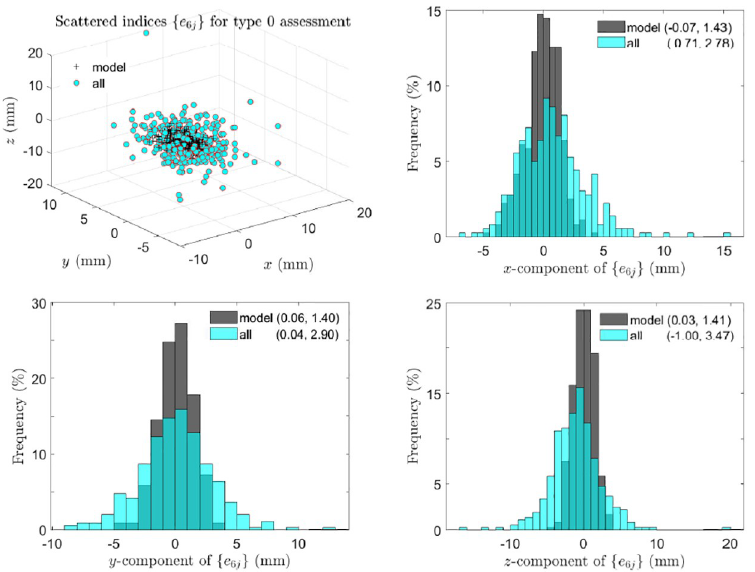
Fig 7. Type 0 assessment: Directional asymmetry of landmark pairs. Scattered points and component histograms of asymmetry indices { e 6 } in type 0 assessment from the 359 perturbed symmetric skull and all real skulls are shown, j where in brackets are the means and standard deviations of components of { e 6 j }.